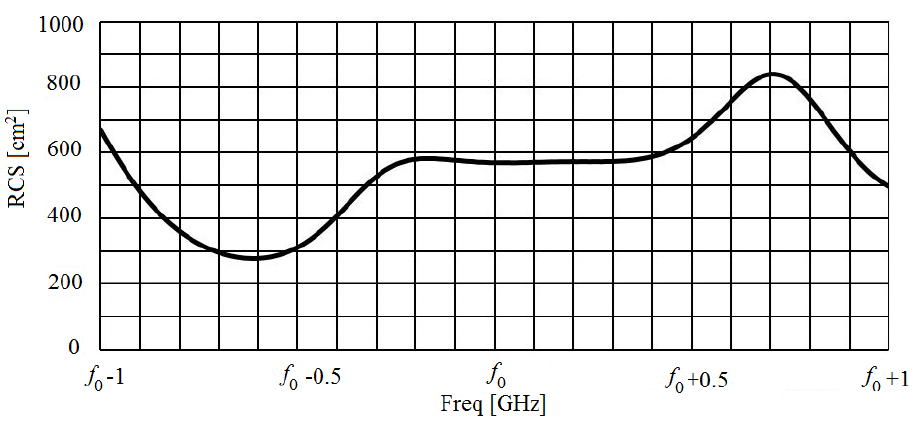
Fig. 7. Parametric reflector modulation RCS diagram.